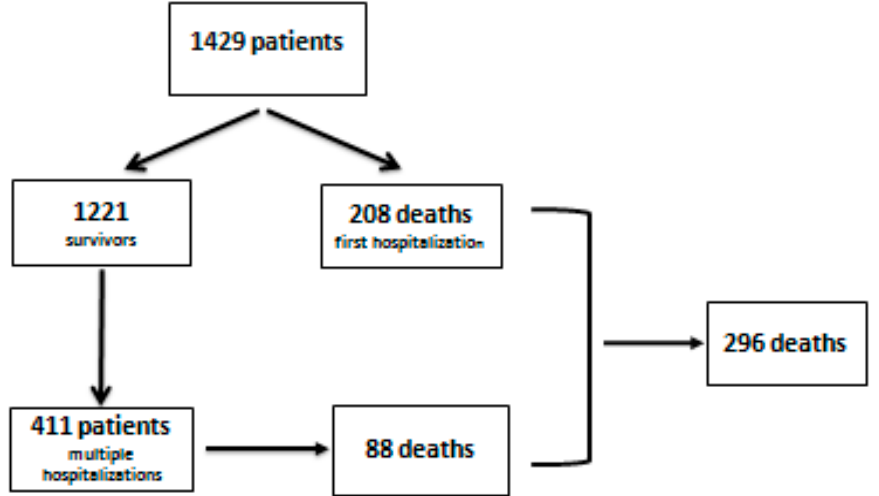
Figure 1. Flow chart of patient selection. Demographic, clinical, paraclinical, and imaging data were collected from the elec- tronic medical records of the patients. We recorded the complications developed during hospitalization, the association of viral hepatitis (hepatitis virus B or hepatitis virus C), condition at discharge, and cause of death. The scores from the model for end-stage liver disease-sodium (MELD-Na) and Child–Turcotte–Pugh (CTP) were calculated during the first hospitalization to assess the severity of the disease. The CTP score was determined according to the presence of ascites, hepatic encephalopathy, bilirubin concentrations, se- rum albumin, and the level of prothrombin time. Using an online scoring calculator (MDcalc MELD-Na), the values for MELD were initially determined based on the formula: 10 × (0.957 × ln [creatinine, mg/dL]) + (0.378 × ln [bilirubin, mg/dL] + (1.12 × ln [INR]) + 6.43. Subsequently, the MELD-Na score was then calculated using the following equation: MELD-Na seric − [0.025 × MELD × (140 − Na seric)] + 140 [10]. The main complications of ALC identified in this study included hepatic encephalopathy, ascites, jaundice, variceal bleeding, spontaneous bacterial peritonitis, and hepatorenal syndrome. Infections, sepsis, acute alcoholic hepatitis, and hepatocarcinoma also had a significant impact on survival. Ascites was clinically identified based on the increased volume of the abdomen and im- aging methods (ultrasound or computer tomography) being confirmed by paracentesis. It was considered as a decompensation of the liver disease, grade 2 and 3 of ascites. Jaundice was diagnosed according to the color changes of the skin and sclera as the consequence of the increased blood level of total bilirubin above 2–2.5 mg/dL [15]. For the classification of hepatic encephalopathy, the West Haven criteria were used, with the diagnosis being established according to the clinical examination and the laboratory values of ammonia. Esophageal and/or gastric variceal bleeding was determined based on clinical findings (hematemesis, melena) determined by an upper gastrointestinal endoscopy [16]. Accord- ing to the EASL guidelines, spontaneous bacterial peritonitis (SBP) was defined as a neu- trophil count ≥ 250 cells/mm 3 , with or without a positive bacterial culture of ascitic fluid collected from a patient without an abdominal source of infection [16]. The criteria used to establish sepsis included the detection of a newly diagnosed dysfunction of an organ, combined with an increase of a sequential organ failure assessment (SOFA score) of more than 2 points associated with a suspected or proven infection. Infections were identified based on the positive result of culture collected from blood, urine, feces, or sputum sam- ples, chest imaging, urine microscopy, or clinical examination compatible with the devel- opment of infection [15]. The establishment of acute alcoholic hepatitis relied on the recent onset of jaundice, with or without other signs of liver decompensation (ascites and/or en- cephalopathy) in individuals who declared heavy alcohol consumption. To diagnose and